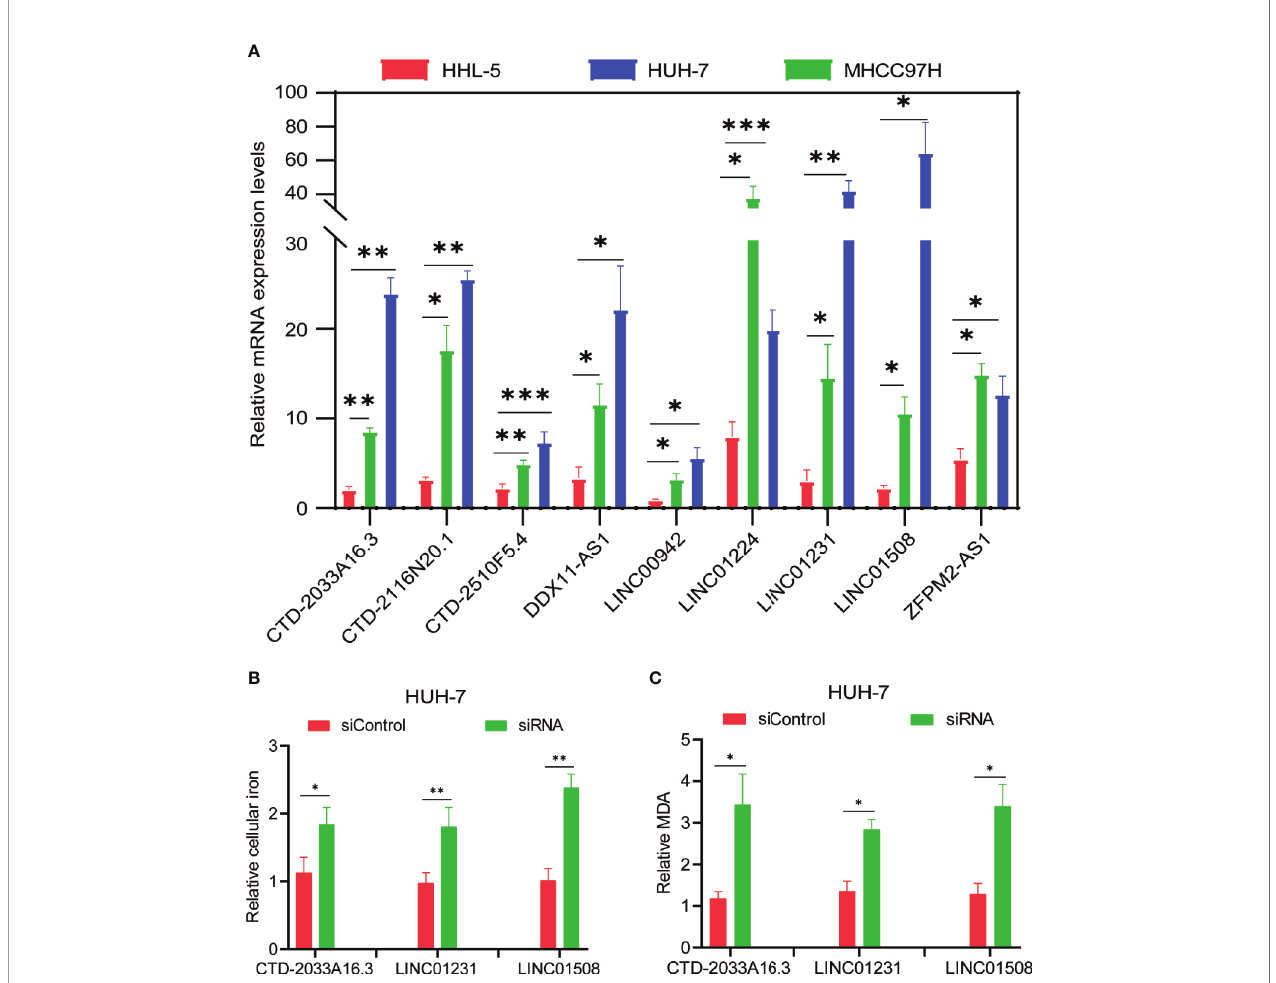
FIGURE 3 | Evaluation of candidate lncRNAs in the ferroptosis of hepatocellular carcinoma cells. (A) The levels of candidate lncRNAs were normalized to 18srRNA. (B) The intracellular iron was analyzed using an iron assay kit. (C) The cellular malondialdehyde concentration was analyzed using a lipid peroxidation assay kit. The values are displayed as mean ± SD for three independent replicates. * p < 0.05, ** p < 0.01, *** p <